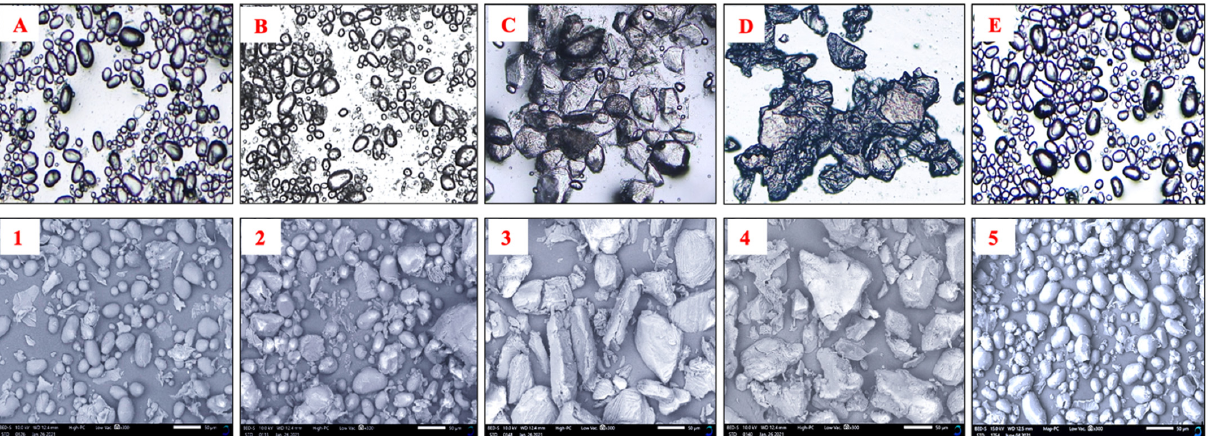
Figure 4. ( A – E ) Light microscopy ( 1 – 5 ) and scanning electron micrographs of potato flour prepared under different conditions. ( A,1 ) Oven drying; ( B , 2 ) blanching at low temperature (60 °C); ( C , 3 ) blanching at high temperature (95°); ( D , 4 ) boiling; ( E , 5 ) freeze drying.